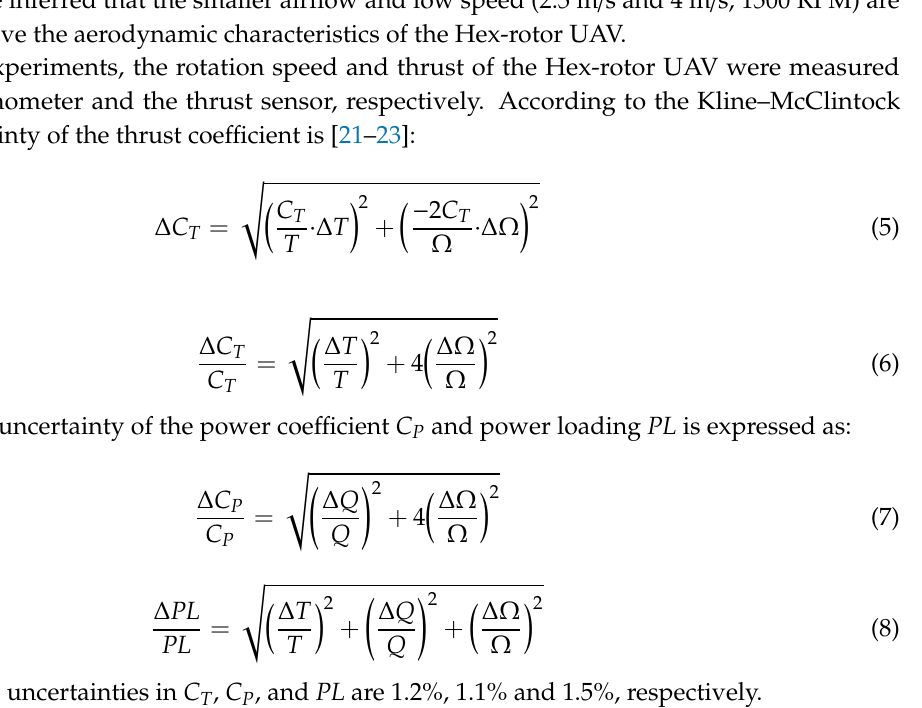
Figure 6. Power loading at different wind speeds.